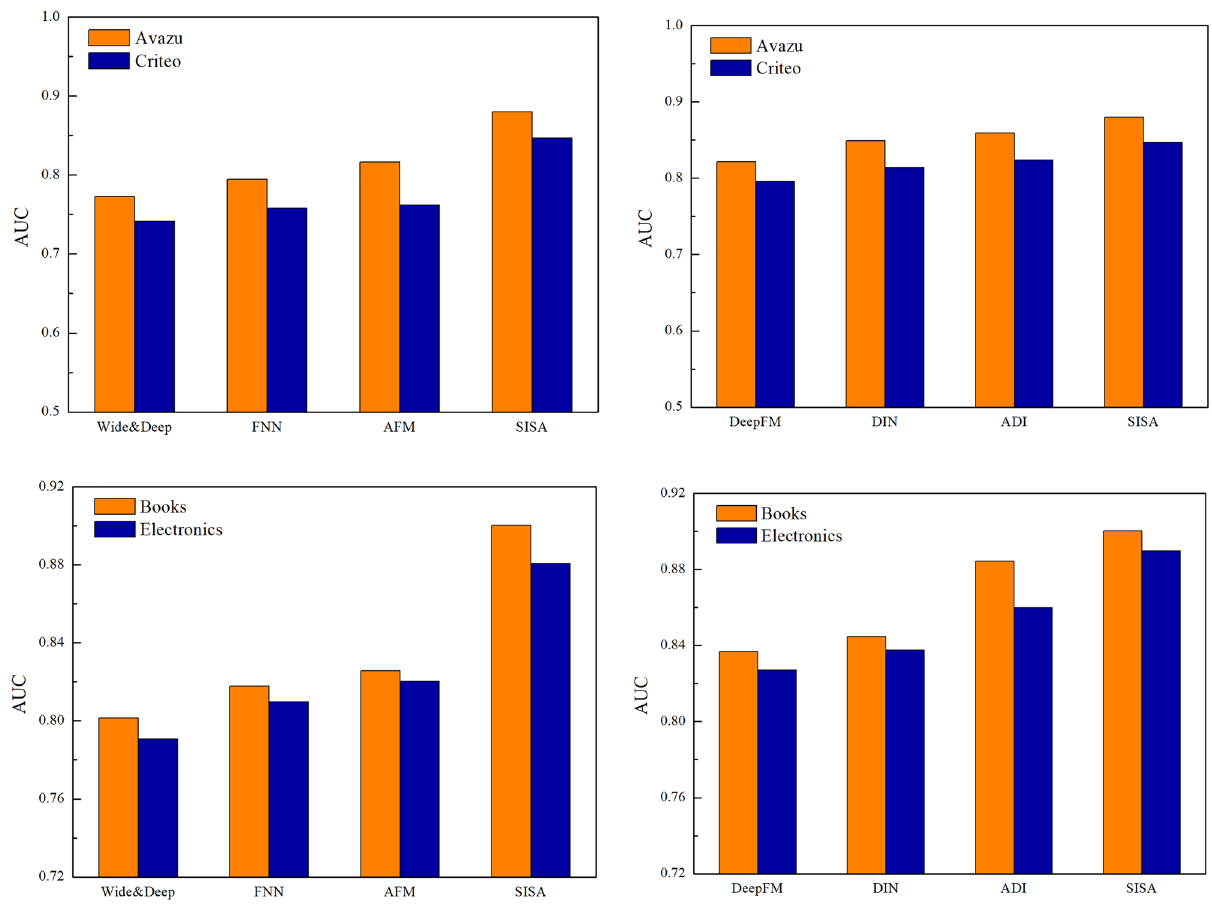
Figure 3. AUC performance comparison with other model.